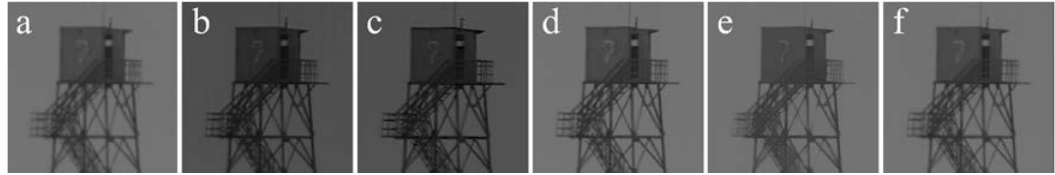
Figure 10. Comparison results for the “Tower.bmp” image: ( a ) blurry image; ( b ) method in [35]; ( c ) method in [36]; ( d ) method in [37]; ( e ) method in [38]; ( f ) proposed method.